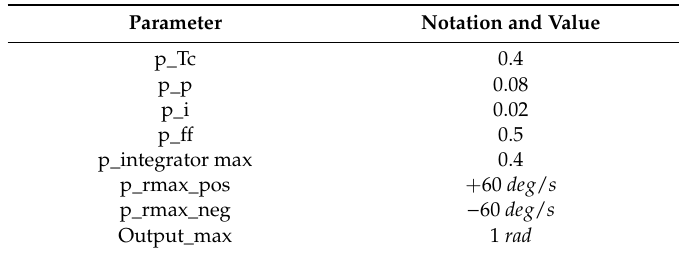
Table A1. Pitch angle control system parameters. Table B1. Pitch angle control system parameters. Table B1. Pitch angle control system parameters.